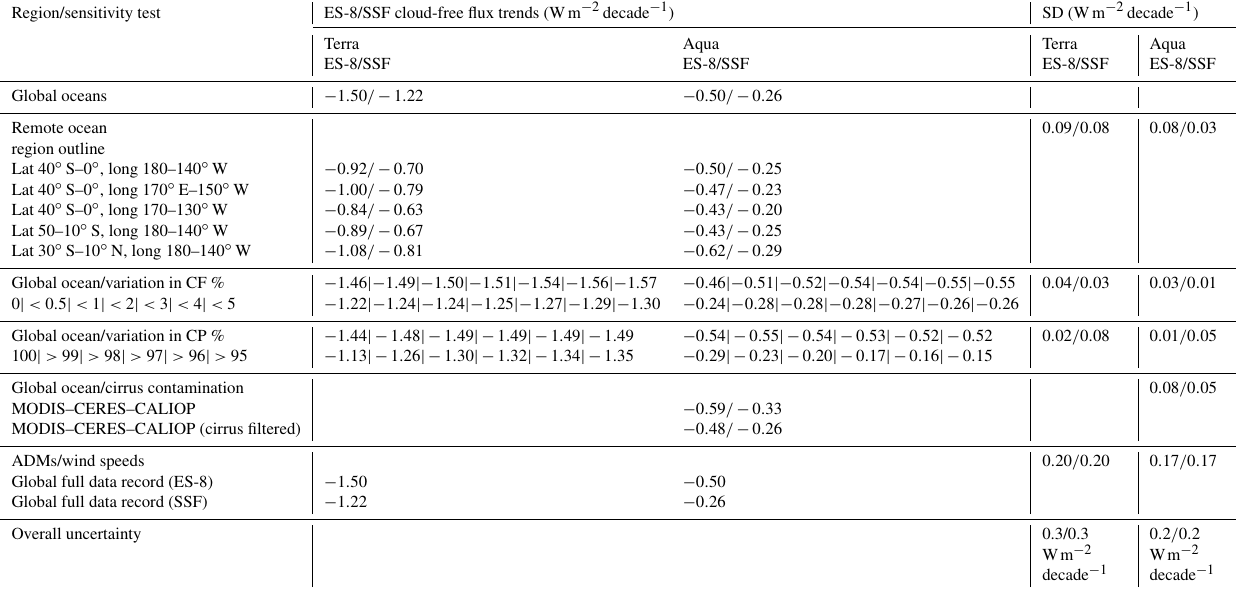
Table 5. List of uncertainty sources (in Wm − 2 decade − 1 ) for the estimated cloud-free SW flux trends. Region/sensitivity